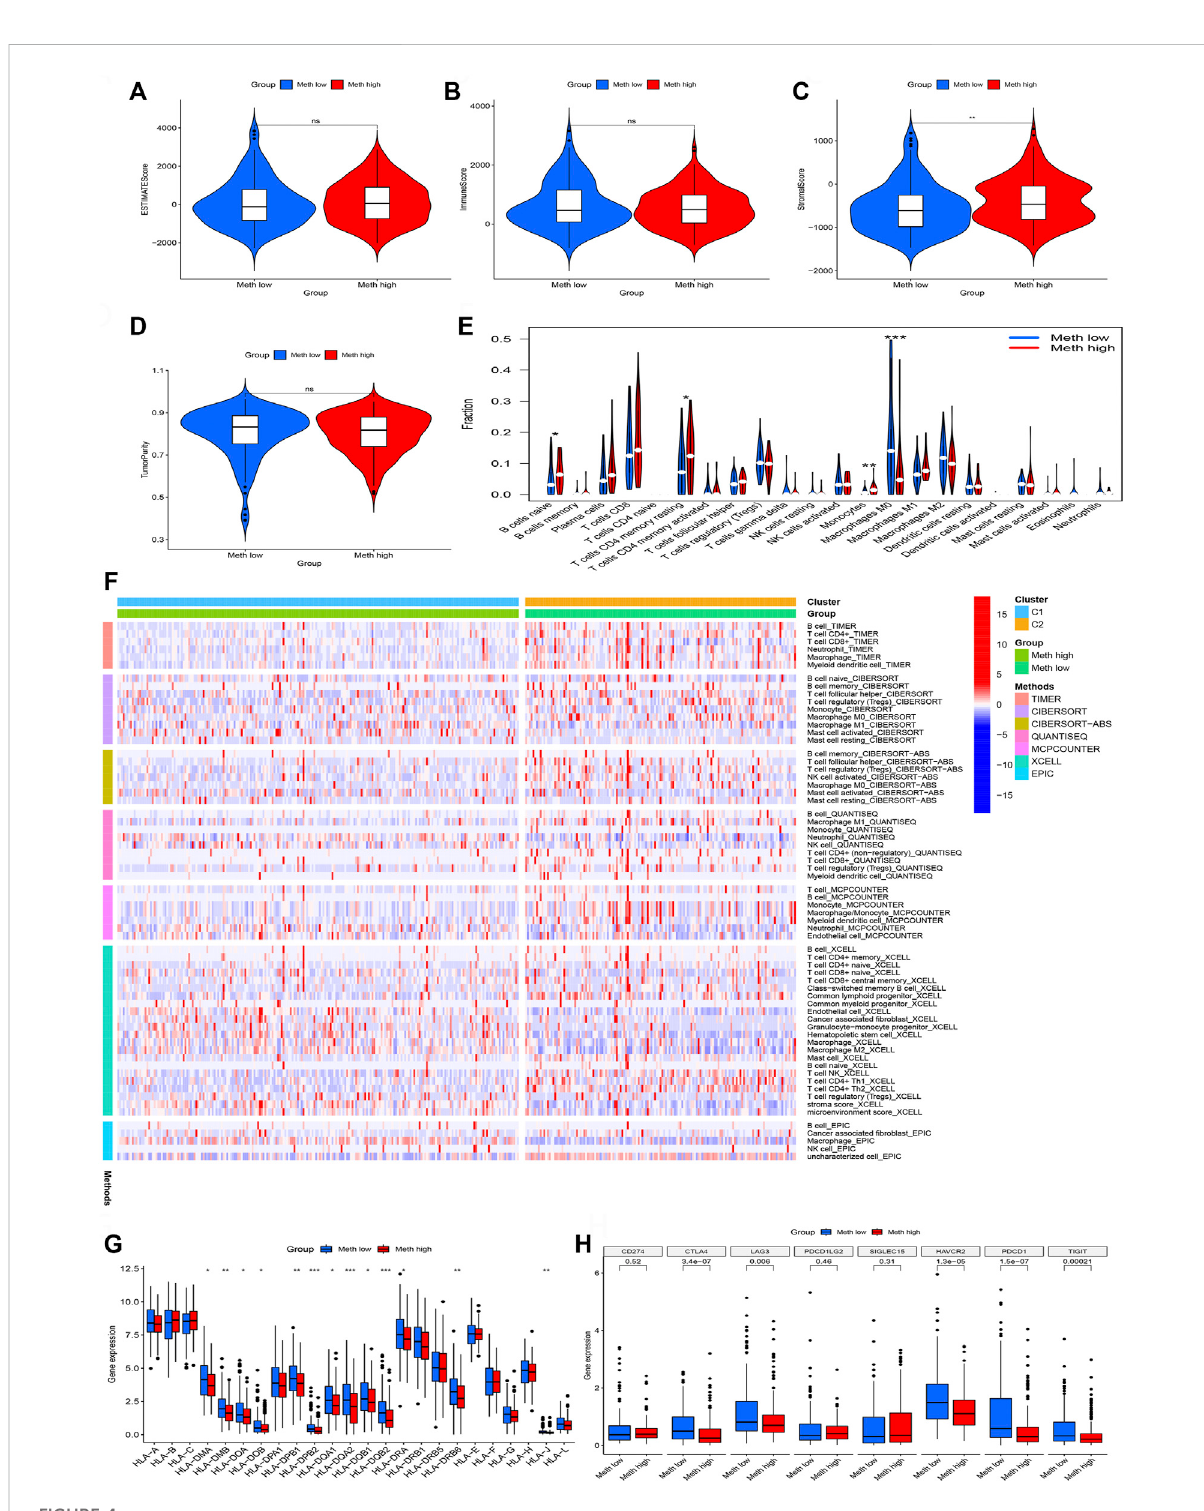
FIGURE 4 Immune cell in fi ltration in two subtypes. (A) ESTIMATE Score in two subtypes. (B) Immune Score in two subtypes. (C) Stromal Score in two subtypes. (D) TumorPurity Score in two subtypes. (E) The violin map based on the CIBERSORT in two subtypes. (F) The heatmap of seven immune methods in two subtypes. (G) The difference between HLA subtypes in two subtypes. (H) The difference between immune checkpoints in two